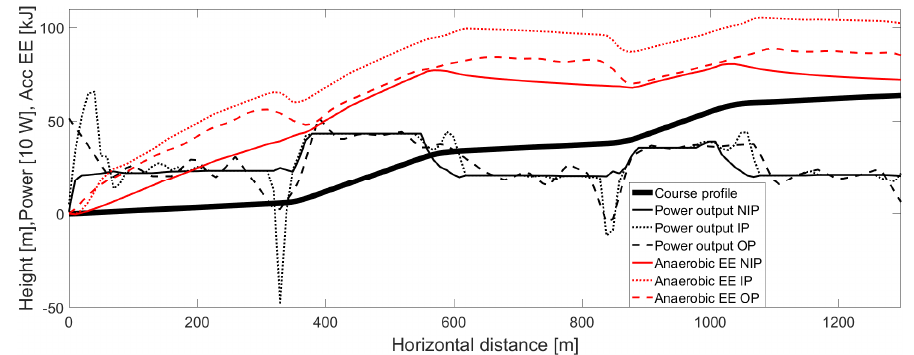
Figure 2. The sprint time-trial course profile, power output distributions, and accumulated anaerobic energy expenditure (EE) profiles of the various power estimates: Non-inertial power estimate (NIP), inertial power estimate (IP), and optimization power estimate